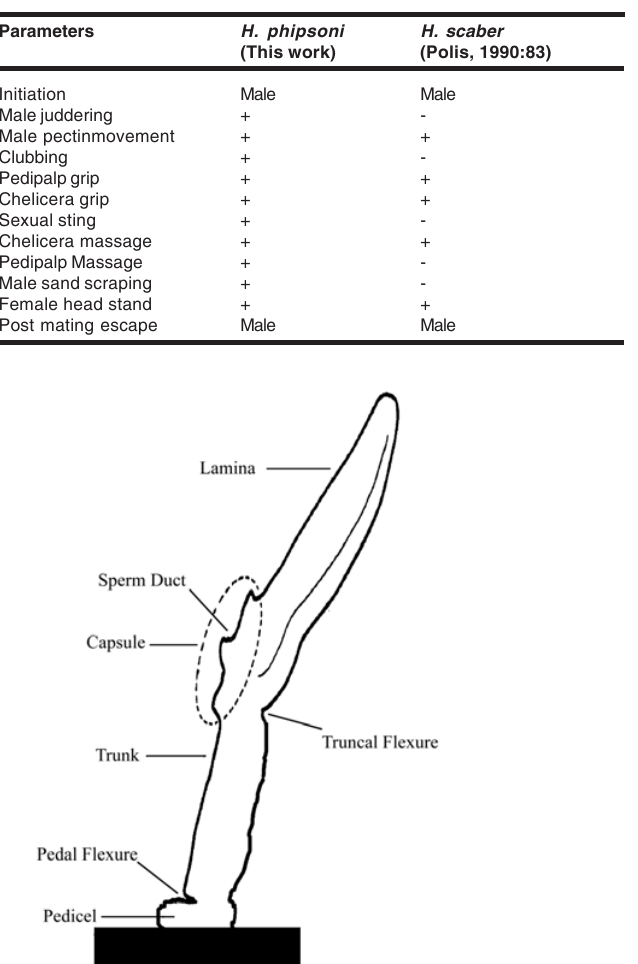
Table 1. Courtship and mating behavior of Heterometrus phipsoni and Heterometrus scaber